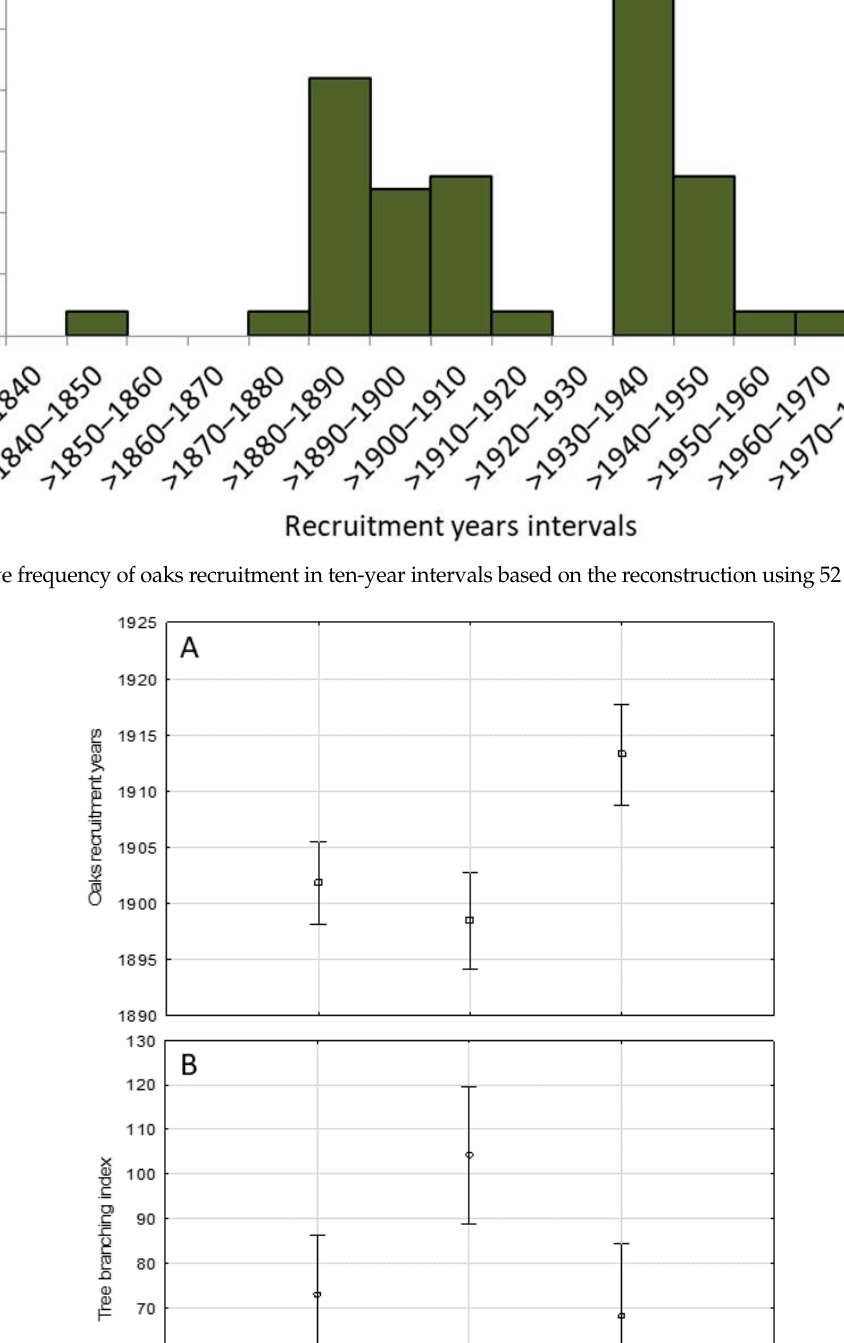
Figure 5. The comparison of average oaks ( A ) recruitment years in three Lisia G ó ra geomorphological forms; means ± 0.95-confidence level; one-way ANOVA, F(2, 293) = 12.126, p = 0.000; ( B ) branching index values in three Lisia G ó ra geomorphological forms: means ± 0.95-confidence level; one-way ANOVA, F(2, 291) = 6.371, p = 0.002.